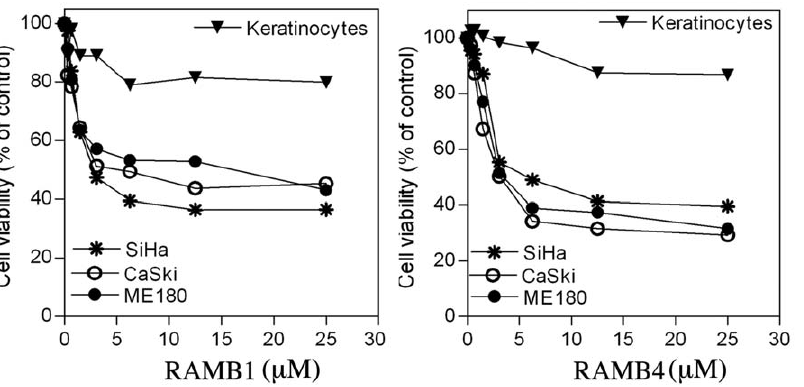
Figure 2. Effect of RAMB treatment upon cervical cancer cell lines and primary human keratinocytes. Cultures of HPV-transformed cervical cancer cells (SiHa, CaSki and ME180) or primary human keratinocytes were treated with the indicated concentrations of RAMB1 ( left panel ) or RAMB4 ( right panel ) over a period of 48 hours. Cell viability was determined by XTT assay and plotted as a fraction of the untreated control cultures.